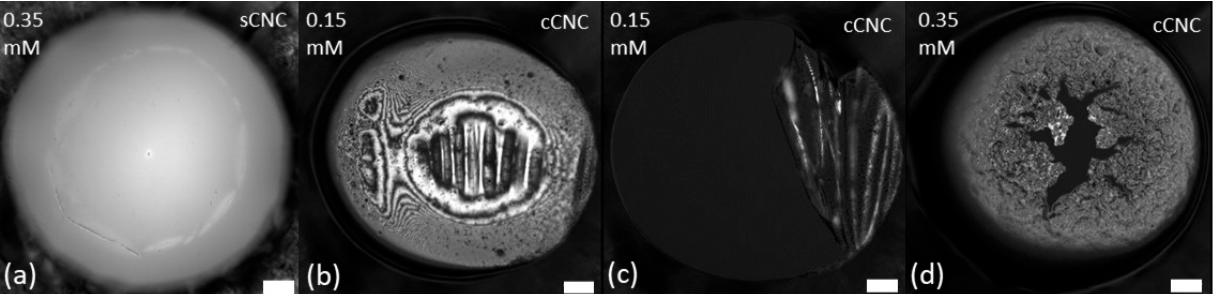
Figure 5. Morphology of LAE ‐ cCNC films after film reforming. Complex interactions of LAE ‐ sCNC ( a ), cCNC ‐ LAE 0.15 mM while reforming the film after rupture ( b , c ) and cCNC ‐ LAE 0.35 mM ( d ). Scale bar 100 μ m.